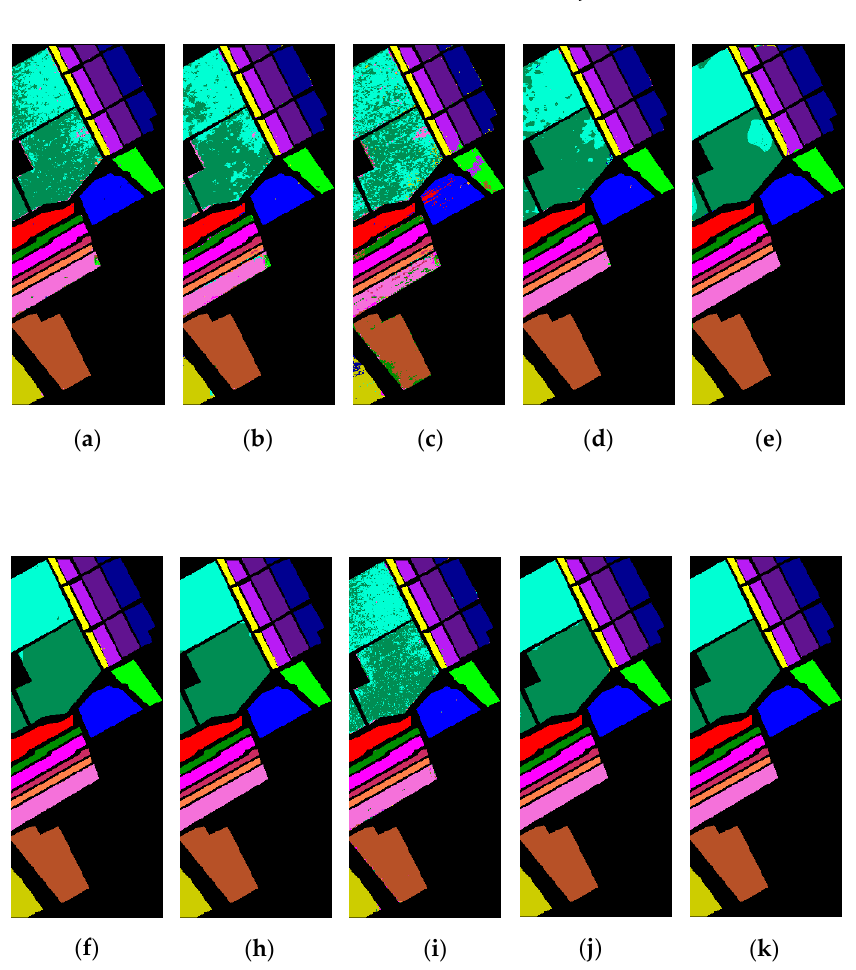
Figure 11. Classification maps of the Salinas dataset. ( a ) SVM 91.89%; ( b ) HiFi-We 91.10%; ( c ) SSG 81.46%; ( d ) EPF 95.92%; ( e ) GSVM 96.93%; ( f ) IFRF 98.86%; ( h ) LPP_LBP_BLS 99.83%; ( i ) BLS 92.00%; ( j ) GBLS 99.84%; ( k ) SSBLS